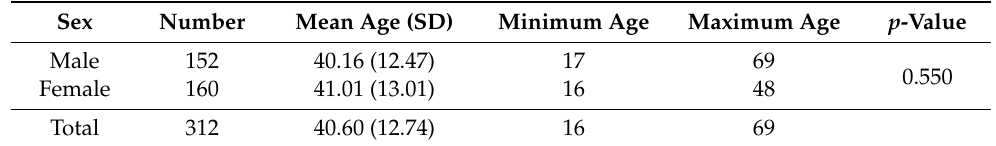
Table 1. Mean and standard deviation of age by sex in the sample.